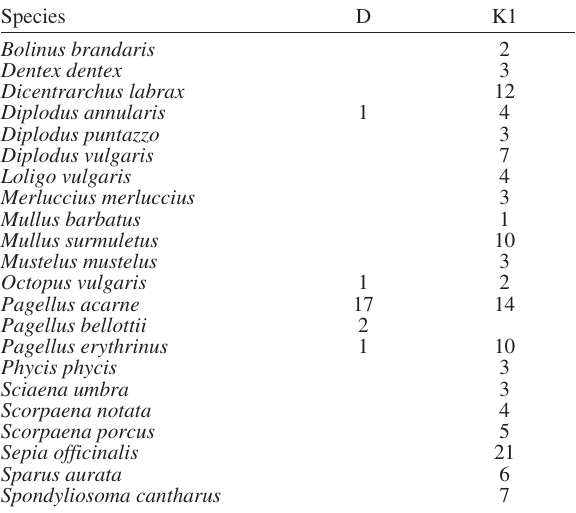
Table 3. – Number of fishing operations in which the commer- cial species indicated would have been discarded and reason: D, undersize individuals; K1, damaged individuals that cannot be commercialized.